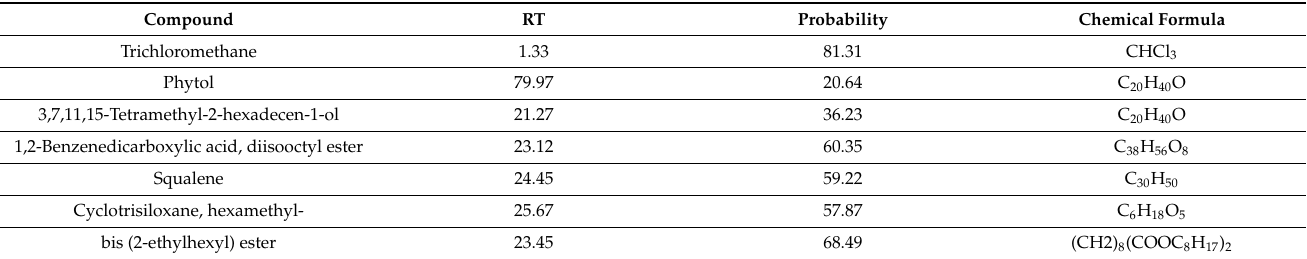
Table 4. Chemical constituents from the gas chromatography mass spectrometry analysis of CF of P. lilacinus .